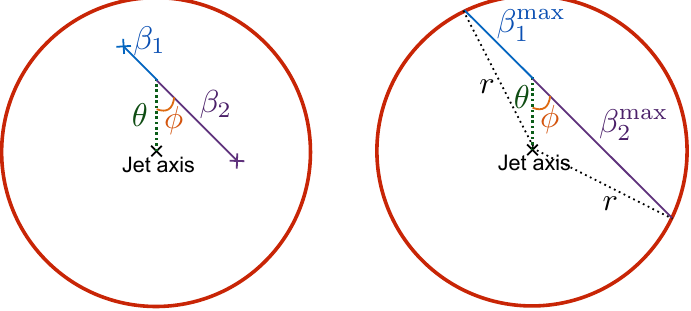
Figure 4 . Projection of the central subjet of radius r onto a plane perpendicular to the jet axis. (cid:18) is the displacement due to recoil and is here assumed to be less than r . In the left panel a splitting is shown. In the right panel (cid:12) max is shown, which is the upper bound on (cid:12) i such that the i corresponding parton lies inside the central subjet.